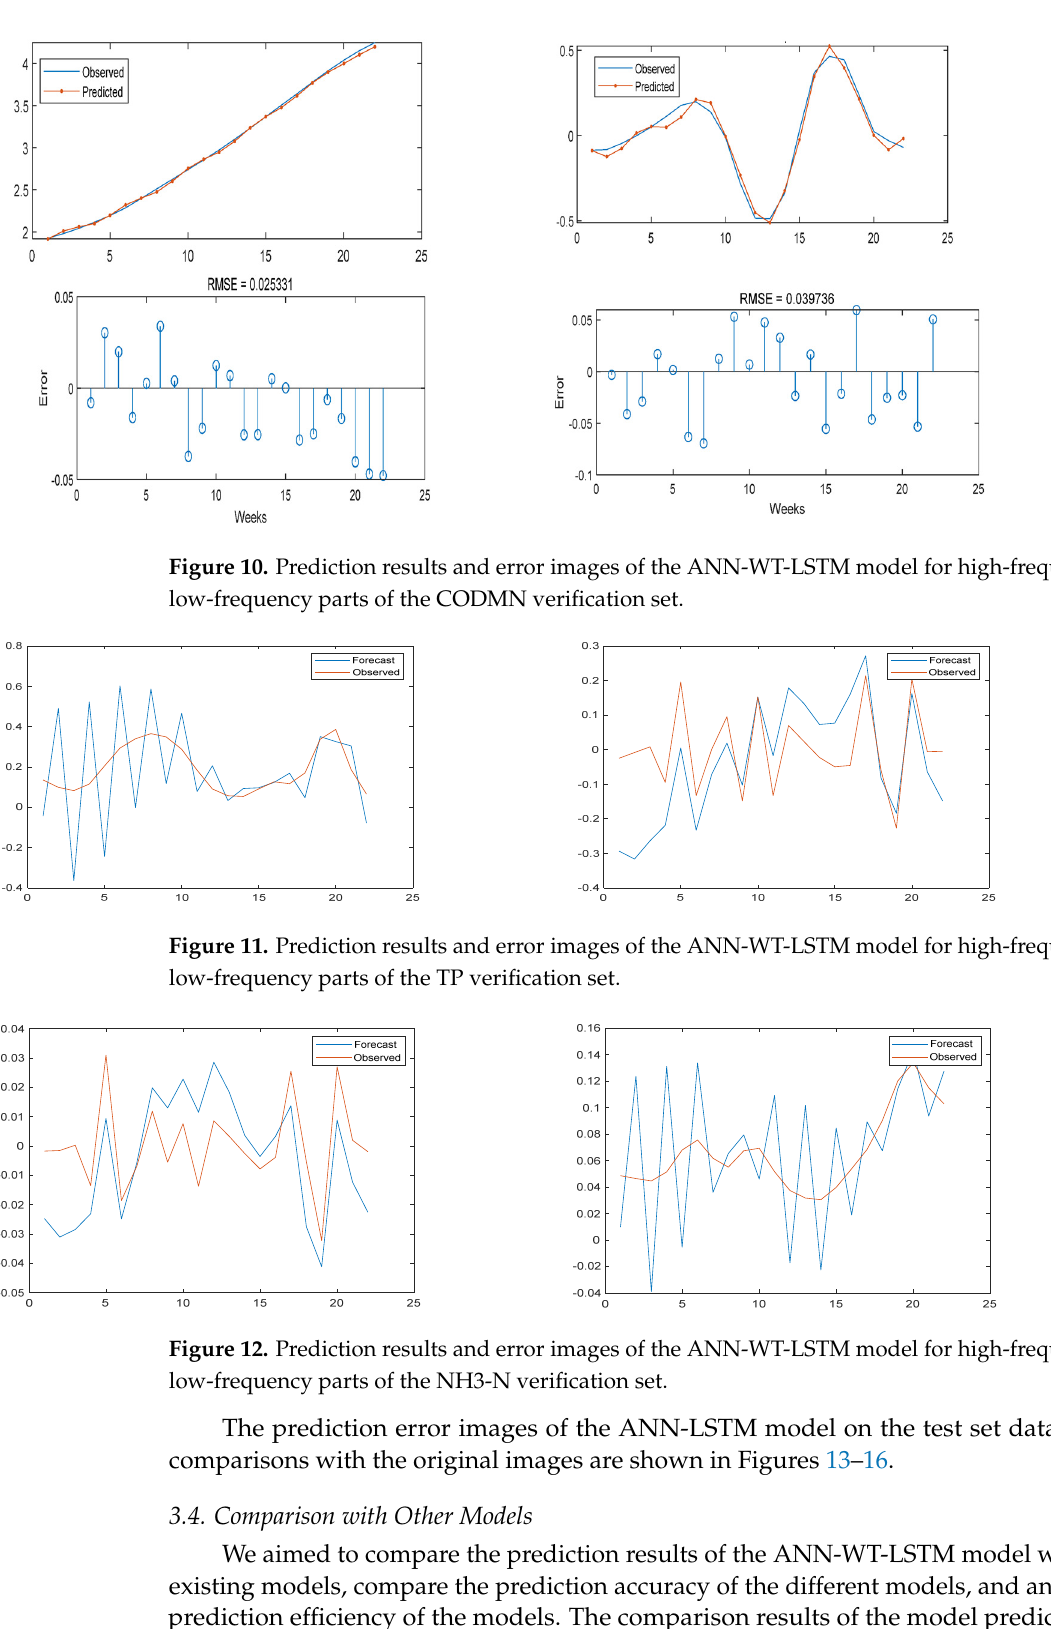
Figure 13. Prediction results of the ANN-LSTM model on the DO test set and comparison with the original image. Figure 14. Prediction results of the ANN-LSTM model on the CODMn test set and comparison with the original image.